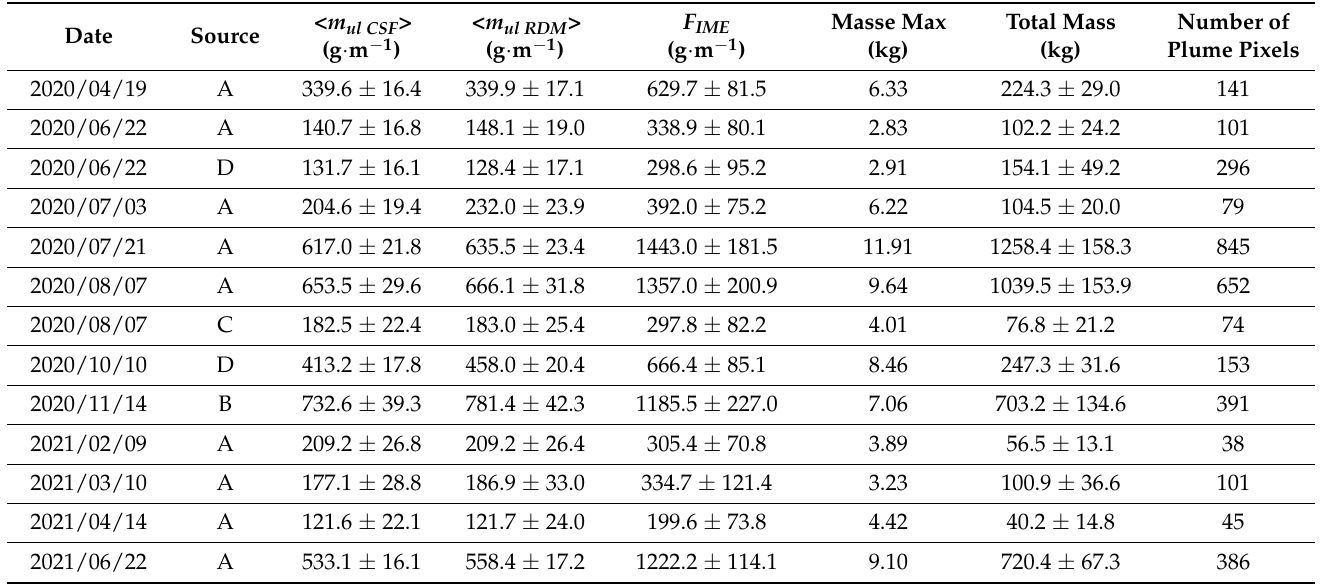
Table A1. Estimation of the wind normalized source flow rate in cases where the small mask is used.